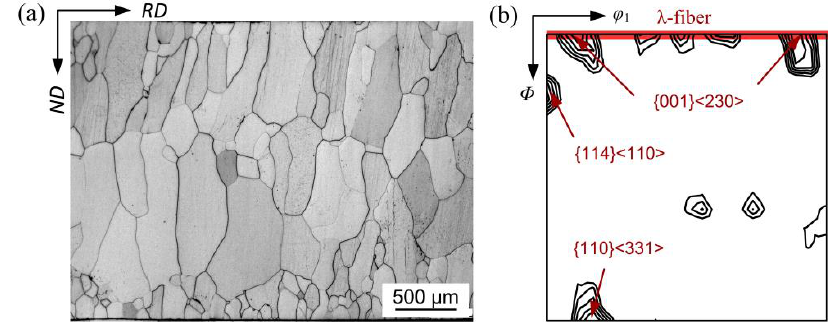
Figure 2. ( a ) metallographic structure of the as-cast strip and ( b ) macro-texture (φ 2 = 45° section of ODFs) of the as-cast